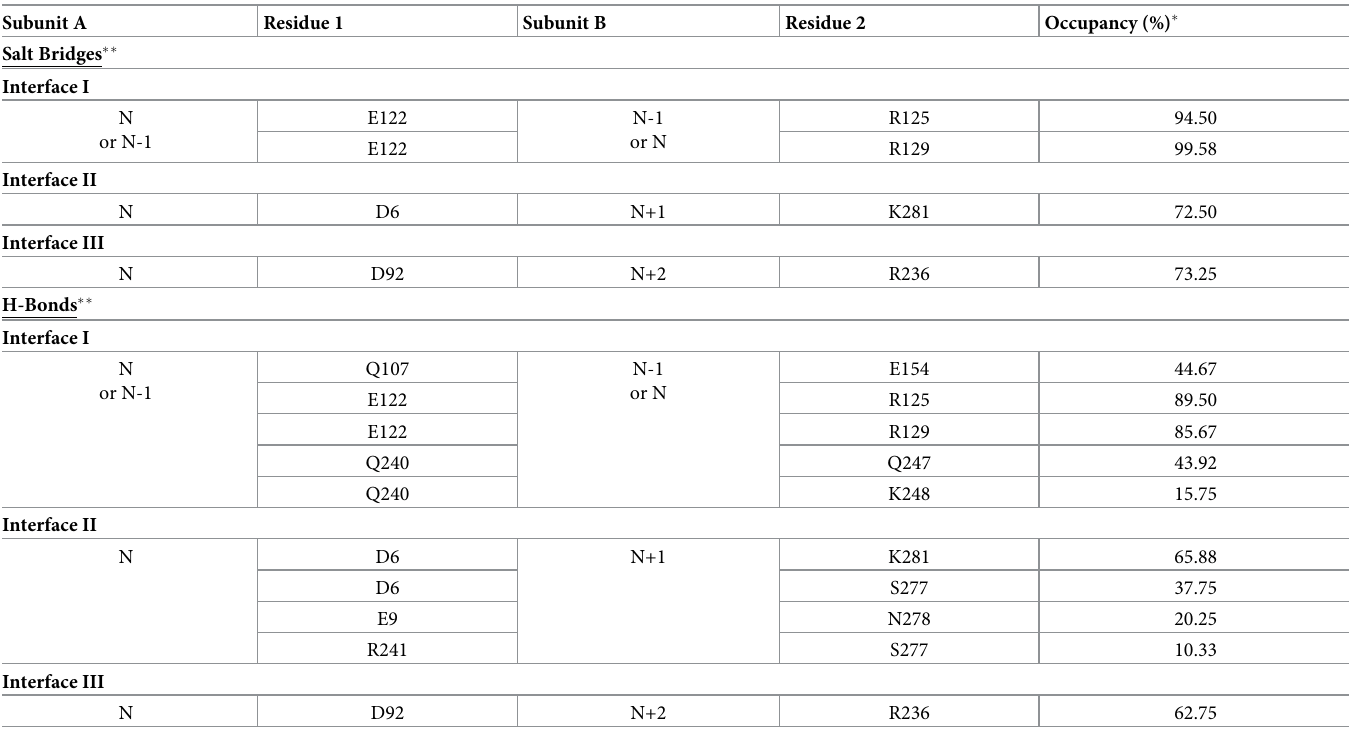
Table 1. Salt bridges/H-bonds between ACAP1 BAR-PH dimers inside the protein